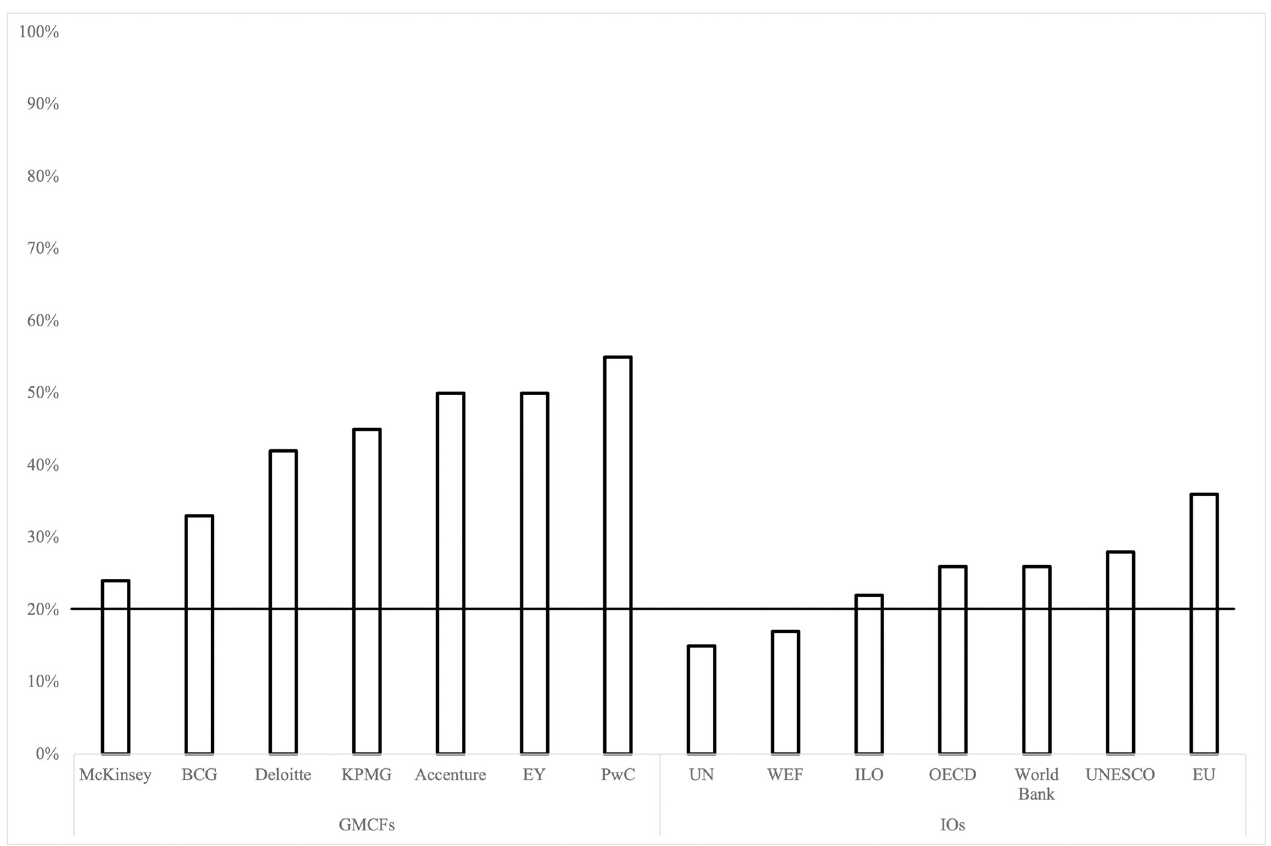
Fig 1. Rates of self-referencing across organizations. Note Fig 1. The horizontal line indicates the 20% threshold for excessive self-referencing.